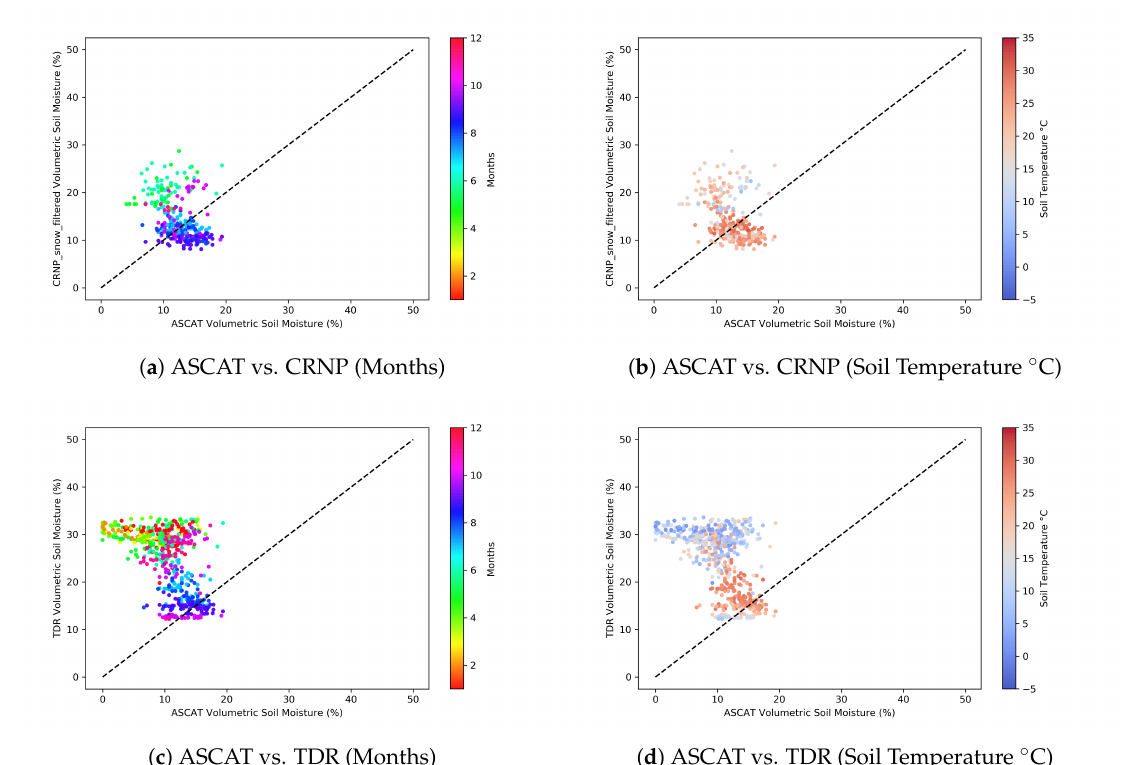
Figure A2. Comparisons between ASCAT Soil Moisture Product with CRNP and